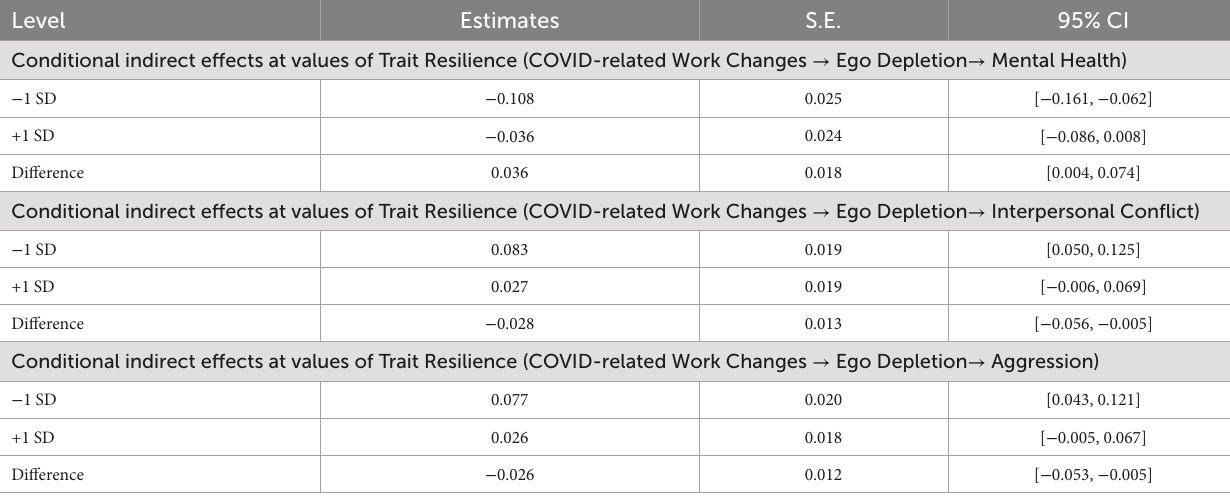
TABLE 4 Summary of conditional indirect effects at values of trait